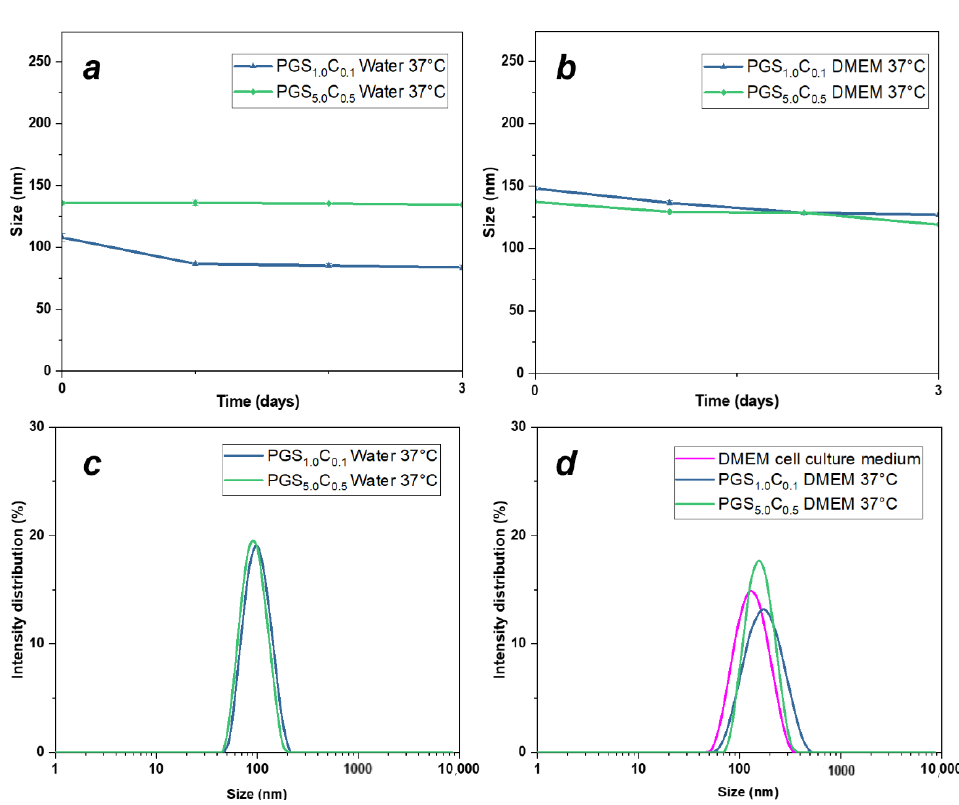
Figure 4. Hydrodynamic diameter of curcumin-loaded PGS-NPs over time from sample preparation in water ( a ) and in DMEM ( b ). DLS size distribution (intensity) of selected loaded PGS-NPs after their dilution in deionized water ( c ) and DMEM cell culture medium( d ) at 37 °C. The same experiment was conducted in cell culture medium. The background